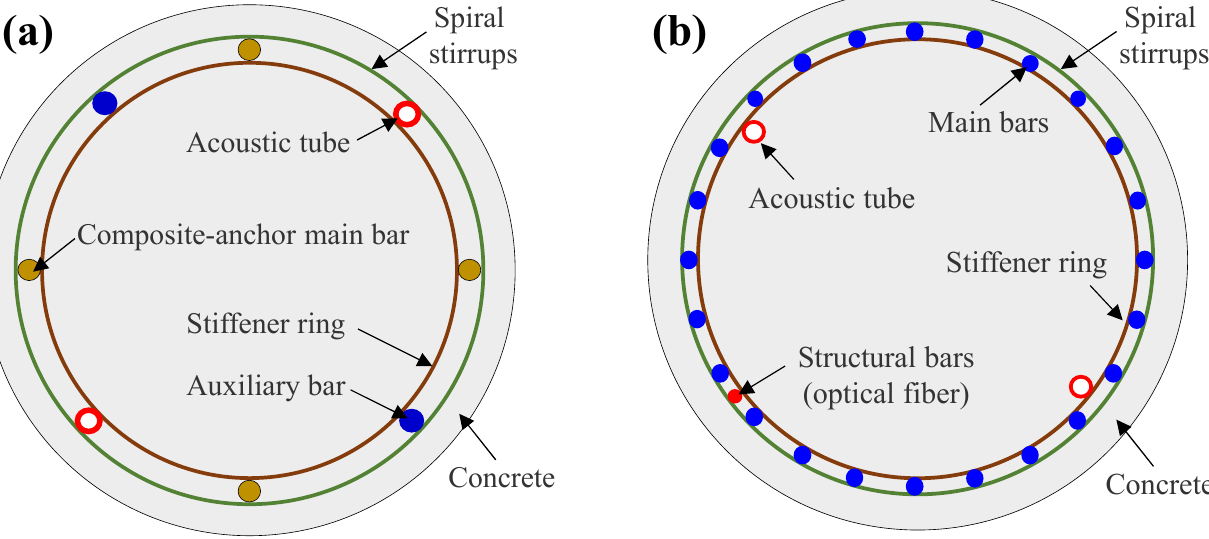
Figure 1. Cross-sectional schematic diagram of the piles in this study: ( a ) the new type of prestressed uplift pile with semi-bonded composite anchor; ( b ) the conventional pile.